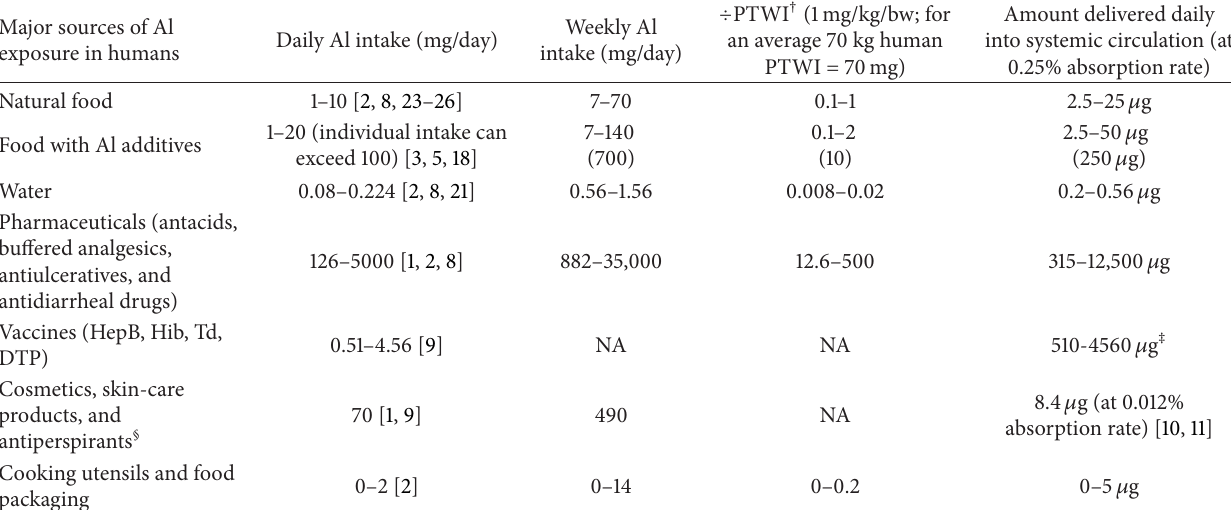
Table 2: Estimates of daily and weekly intakes of Al in humans [28, 74].